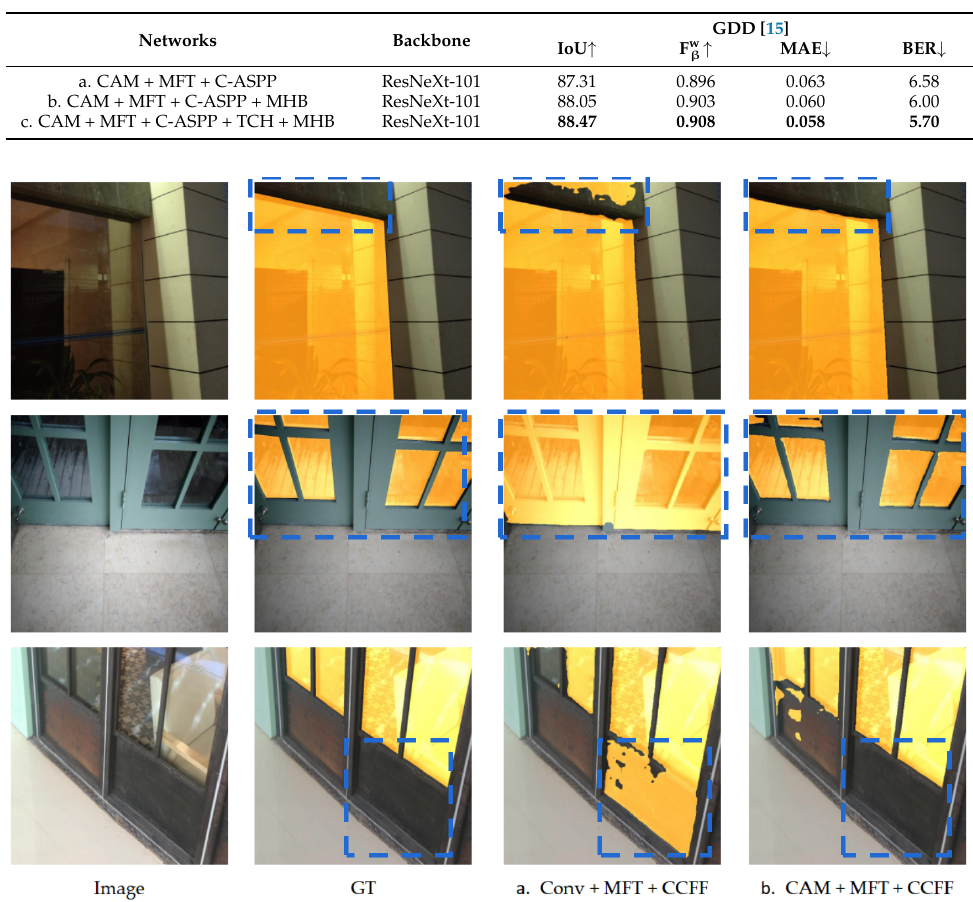
Figure 11. Comparison of results of CAM module ablation experiments. ( a ) uses the convolution method and ( b ) uses the CAM module.